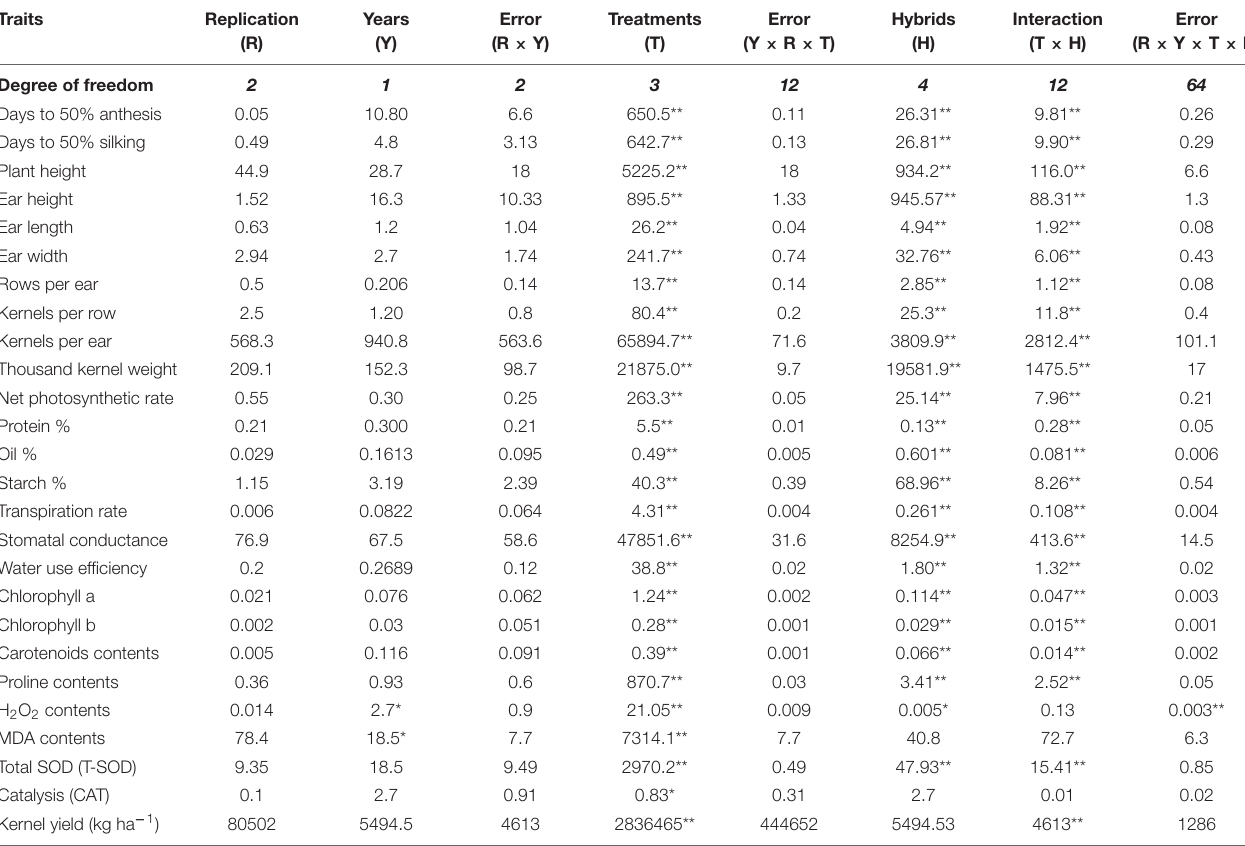
TABLE 1 | Mean Squares (MS) of plant traits in five maize hybrids under individual and combined heat and drought stresses. Traits Replication